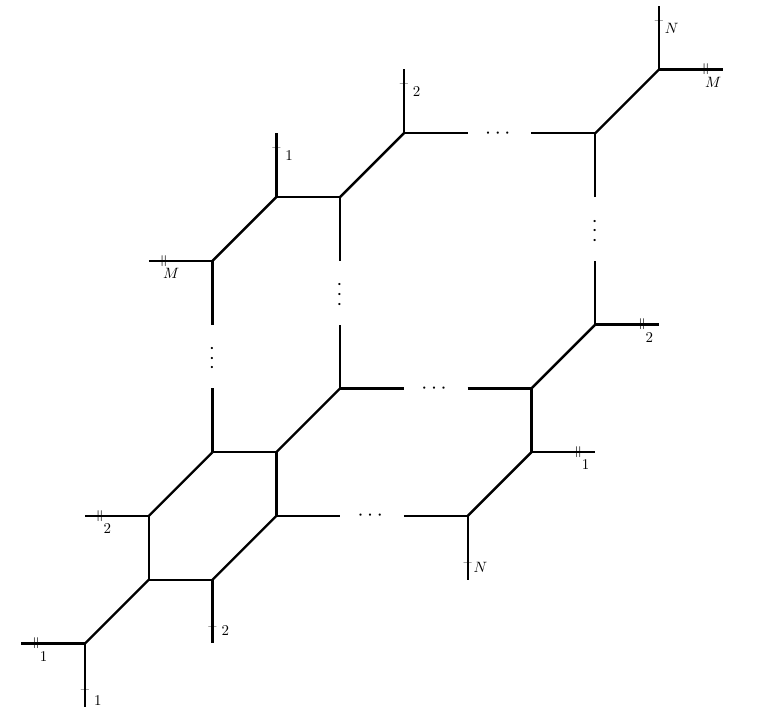
Figure 1 . Web Diagram of the toric Calabi-Yau manifold X N;M . The vertical and horizontal lines are glued together as indicated by the labels of the outermost